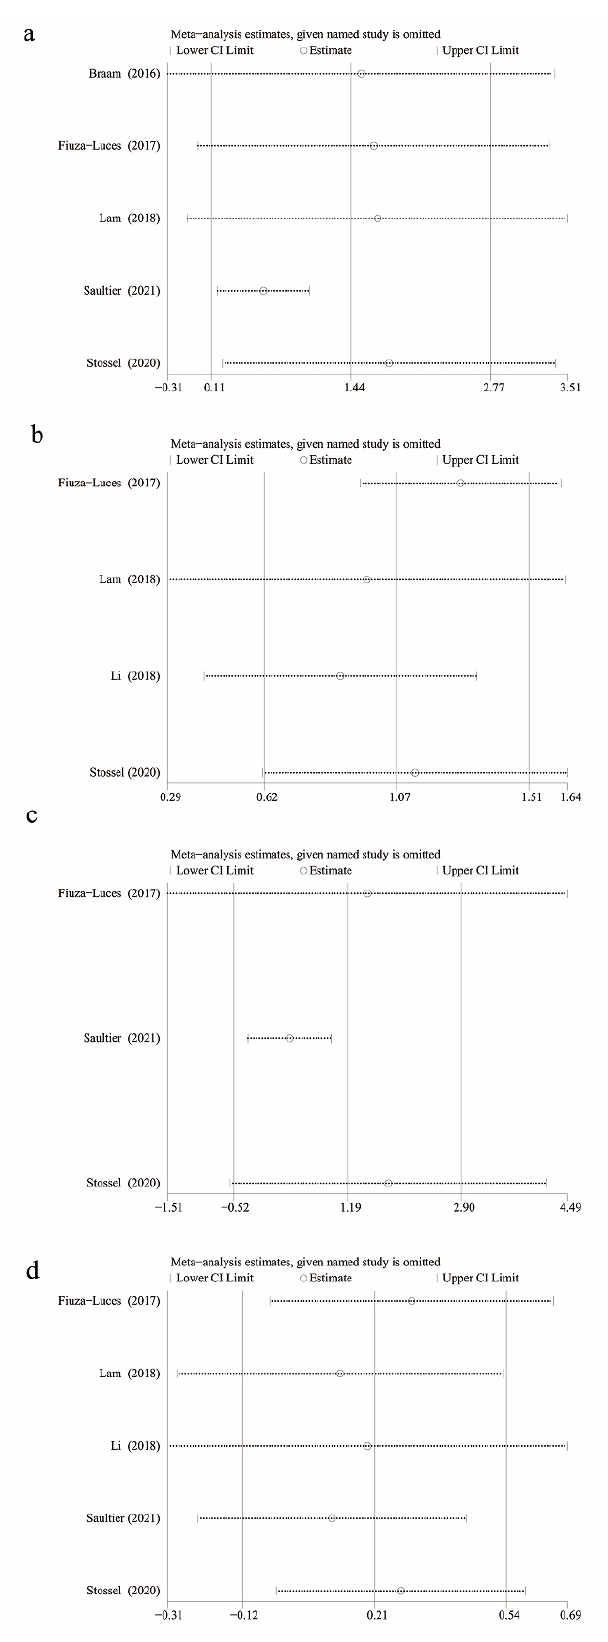
Figure 4. Sensitivity analysis of ( a ) muscle strength, ( b ) level of daily physical activity, ( c ) BMI, and ( d ) QoL.